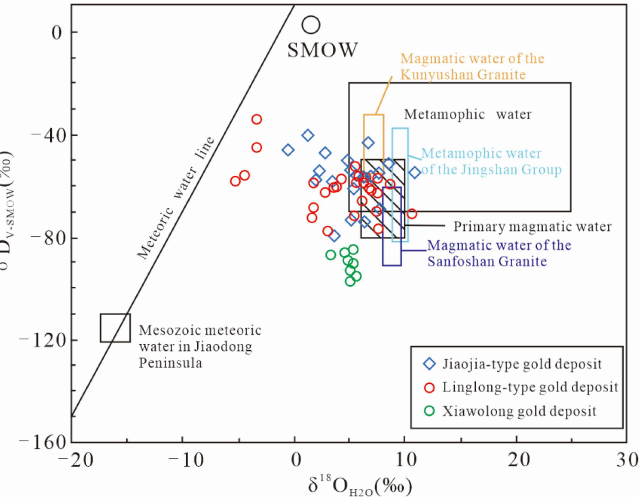
Figure 9. Calculated δ D and δ 18 O values of ore-forming fluids in the Xiawolong gold deposit. Data for the areas of magmatic water of the Kunyushn granite, magmatic water of the Sanfoshan granite, metamorphic water of the Jinshan Group, and the “Jiaojia-type” and “Linglong-type” gold deposits are from [20,61] and references therein. Adapted with permission from Ref. [20]. 2017,